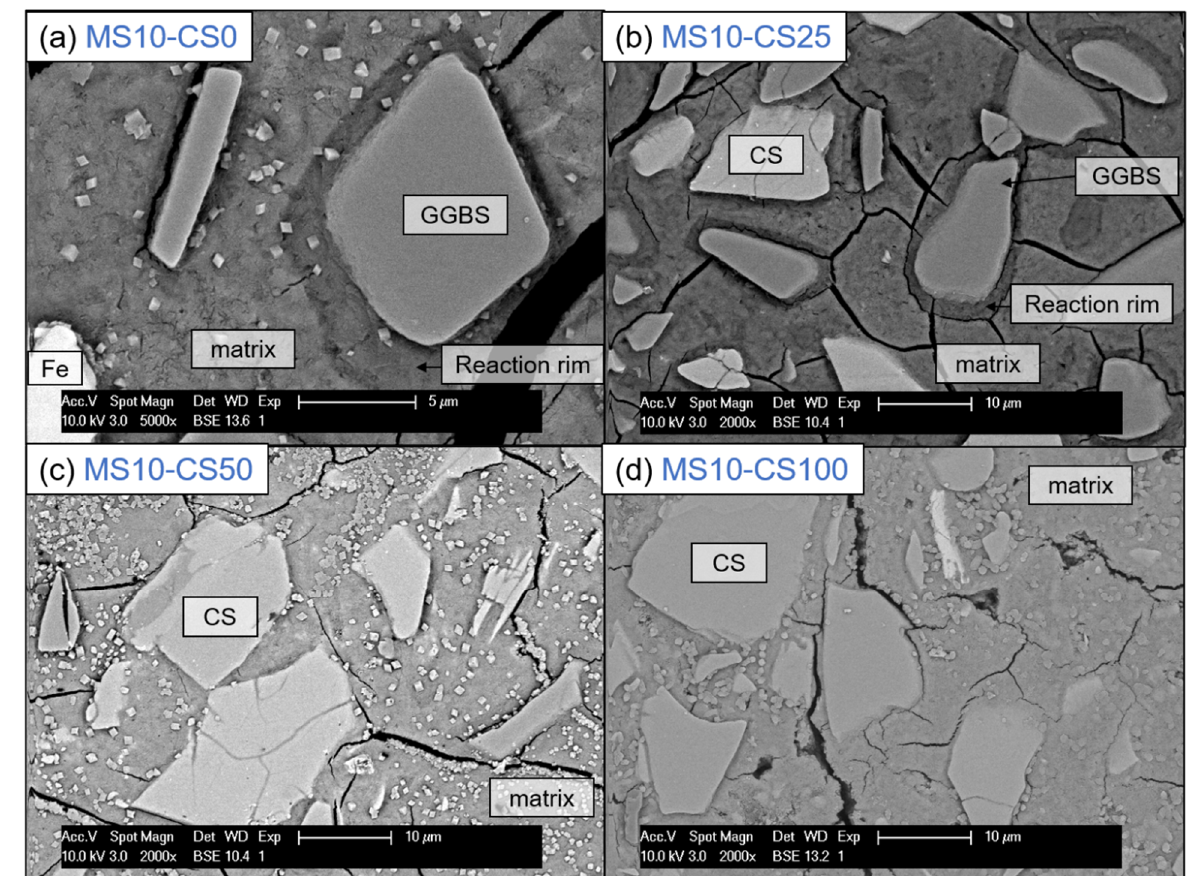
Figure 12. SEM-BSE imaging at 5000× ( a ) and 2000× ( b – d ) magnification of 10 wt% metasilicate systems. Slag composition varies from ( a ) 100 wt% GGBS, 2-MS10CS0, ( b ) 75 wt% GGBS, 25 wt% CS, 9-MS10CS25, ( c ) 50 wt% GGBS, 50 wt% CS, 8-MS10CS50 to ( d ) 100 wt% CS, MS10CS100. Cracking observed can be due to vacuum treating the samples before BSE analyses. Magnification of ( a ) is higher to show the reaction rim enlarged (See Table 2 for mix design).